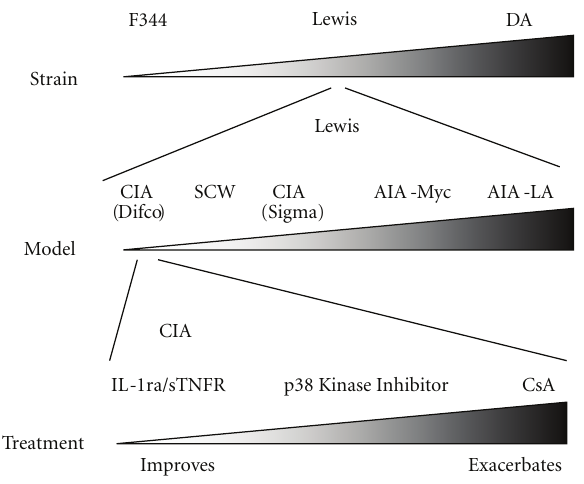
Figure 1: The ability to model immune-mediated disease is a ff ected by many factors, including the animal strain (top triangle), the choice of model (middle triangle), and the nature of the antiarthritic molecules being tested (bottom triangle). For rat strains, susceptibility to arthritis is highest in DA and lowest in F344 animals. For rat model systems, the adjuvant-induced arthritis (AIA) variants are more aggressive than are the collagen- induced arthritis (CIA) and streptococcal cell wall (SCW) versions; furthermore, the extent of AIA lesions depends on the inciting agent (lipoidal amine (LA) versus heat-killed Mycobacterium (Myc)), while the severity of the CIA lesions is more extensive if the source of incomplete Freund’s adjuvant (IFA) is Sigma Chemical Co. (St. Louis, MO) rather than Difco Laboratories (Detroit, MI). With regard to treating rats with CIA, the greatest improvement in joint disease is achieved using the cytokine-inhibiting biologics interleukin-1 (IL-1) receptor antagonist (IL-1ra) and soluble tumor necrosis factor (TNF) receptor (sTNFR) and intermediate using small molecule blockers of p38 kinase (which regulates IL-1 and TNF). Depending on the treatment window, cyclosporin A (CsA) will inhibit, delay, or even exacerbate arthritis in Lewis rat CIA (compare also to Figure